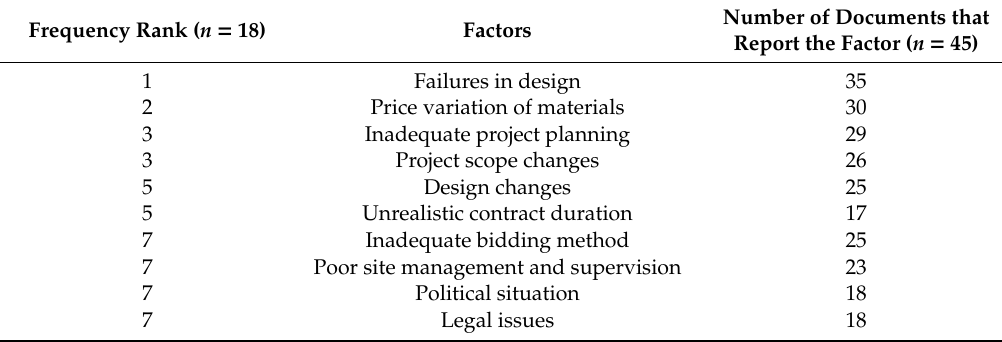
Table 5. Top-10 cost overrun factors and number of documents that report the